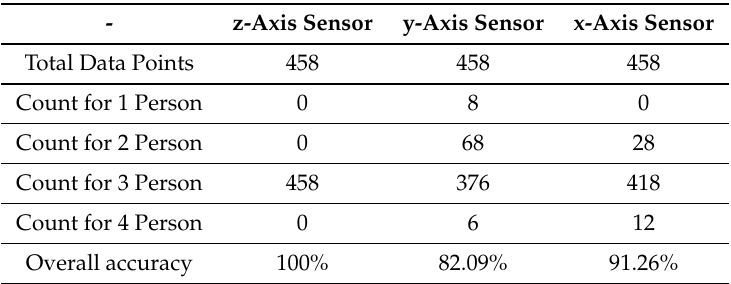
Table 7. Connected component: three people sitting.